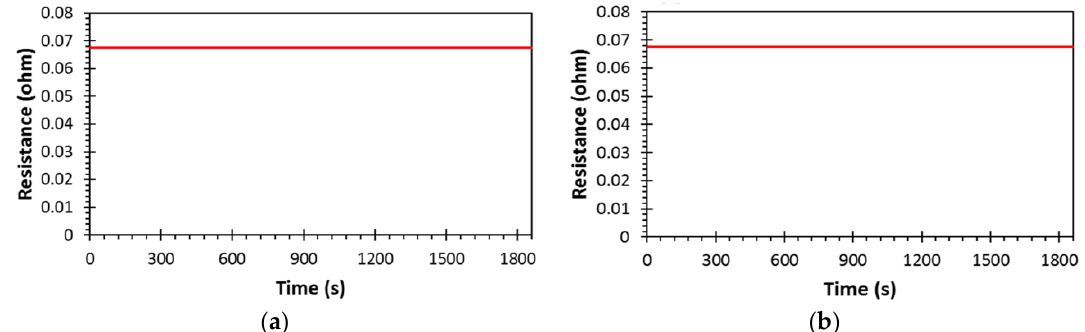
Figure 23. The total electrical resistance of the single railway track by totalling the electrical resistance of the changing electric network configuration of: ( a ) Section 1; and ( b ) Section 2.